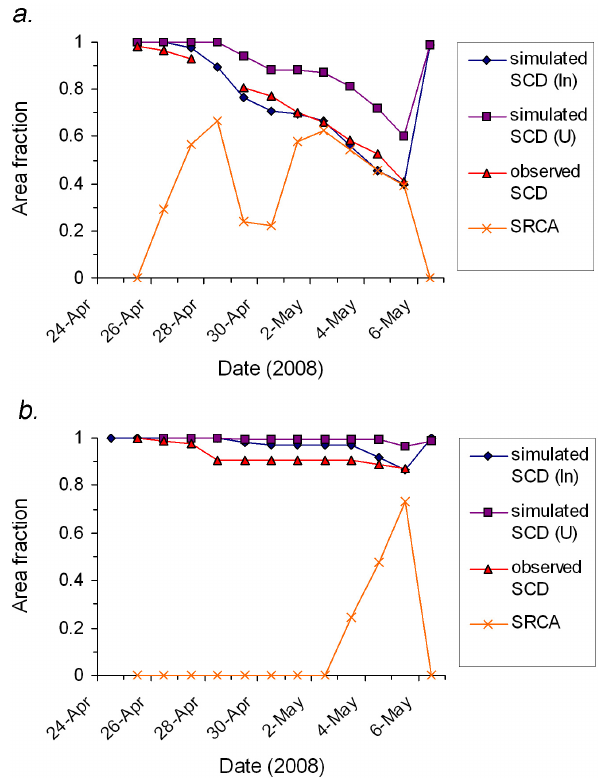
Fig. 5. Simulated vs. observed SCD curves and the SRCA during the early melt period within the Mt. Allan cirque in 2008: (a) South- facing slope unit; (b) North-facing slope unit. SCD curves were de- rived based on inhomogeneous melt (In) from computations based on different initial SWE values, and from uniform slope-based melt (U) based on a single value of SWE and applied across the SWE distribution. Observed SCD curves were derived from the orthogo- nally corrected photographs of the